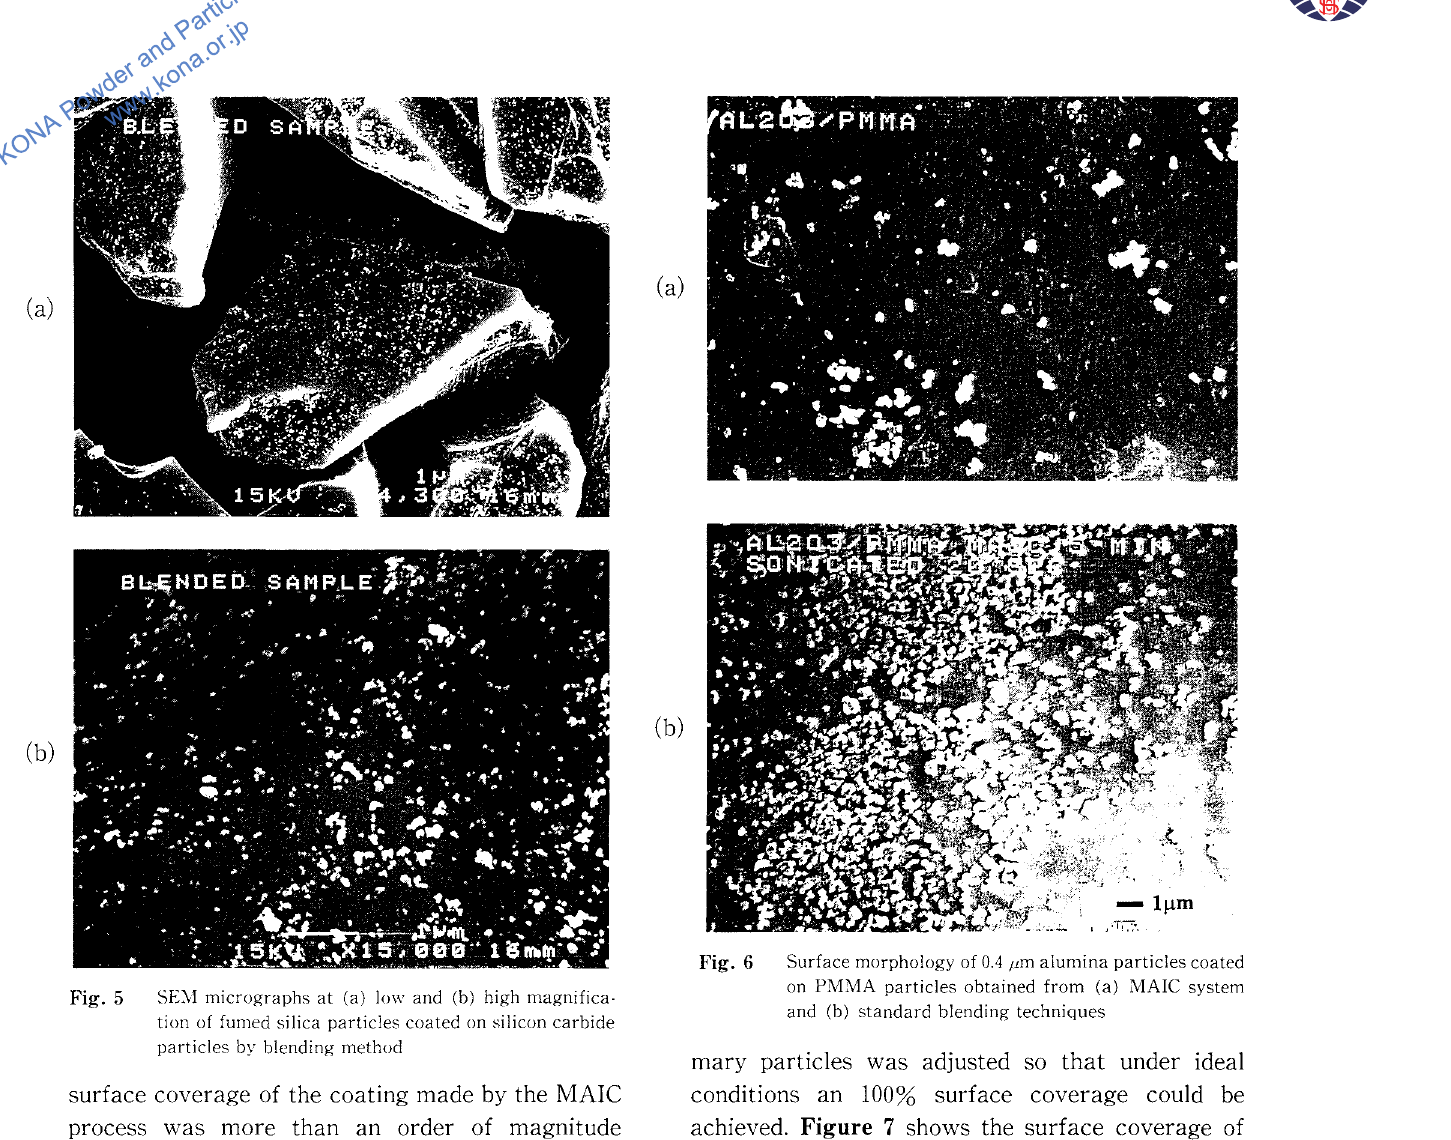
Fig. 6 Surface morphology of 0.4 11m alumina particles coated on PM:v!A particles obtained from (a) MAIC system and (b) standard blending techniques mary particles was adjusted so that under ideal conditions an 100% surface coverage could be achieved. Figure 7 shows the surface coverage